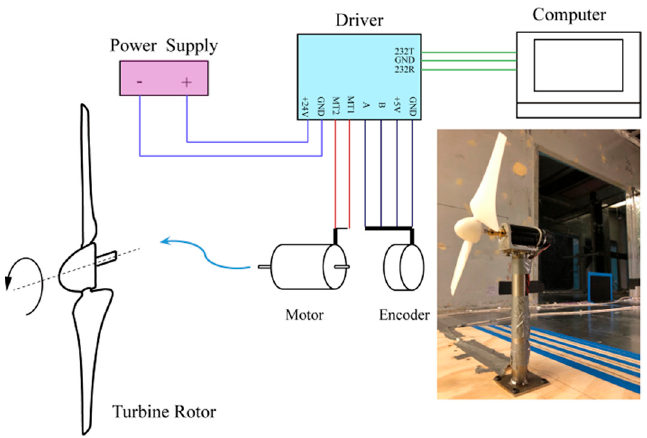
Figure 6. Photograph of the system for the active driving mode.